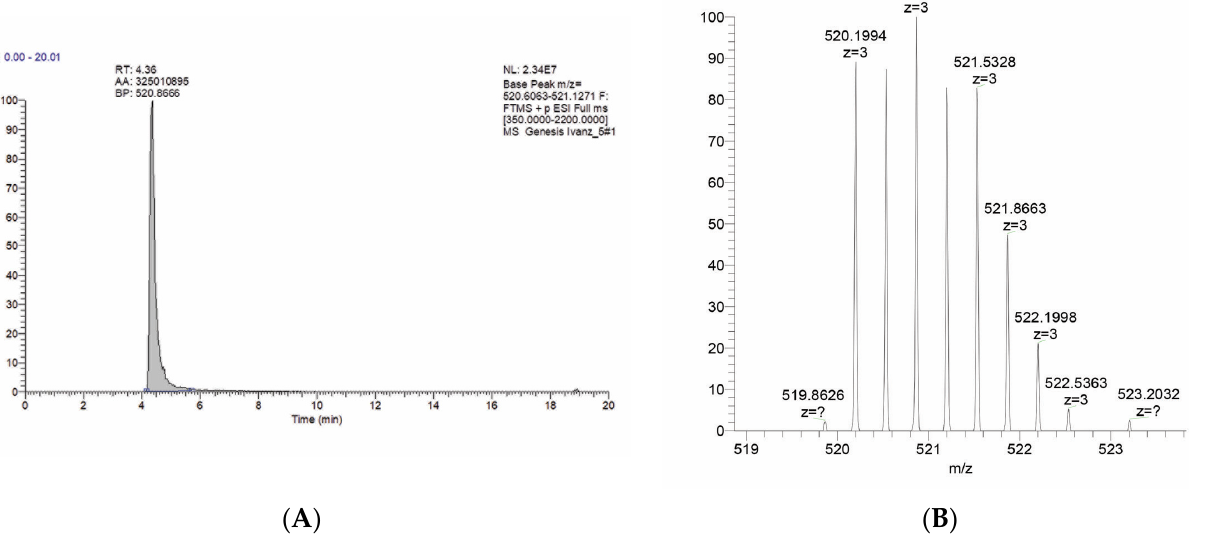
Figure 1. ( A ) Mass chromatogram of target compound 7 ; the retention time of the target compound is 4.38 min. ( B ) Fragment of mass spectrum of 7 m / z [M+H] 3+ = 520.8666.